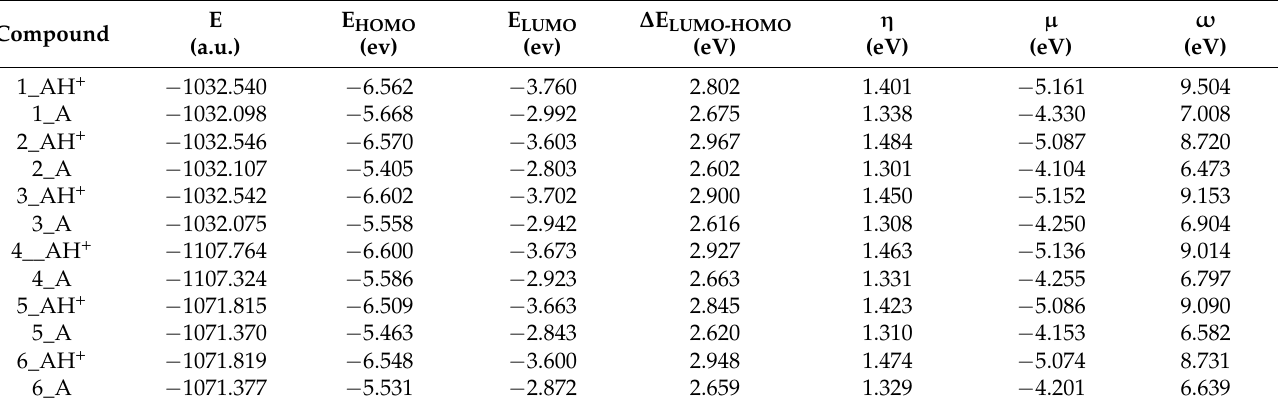
Table 1. Energetic parameters and reactivity descriptors of the flavylium dyes computed at the B3LYP/6-31+G (d, p) level of